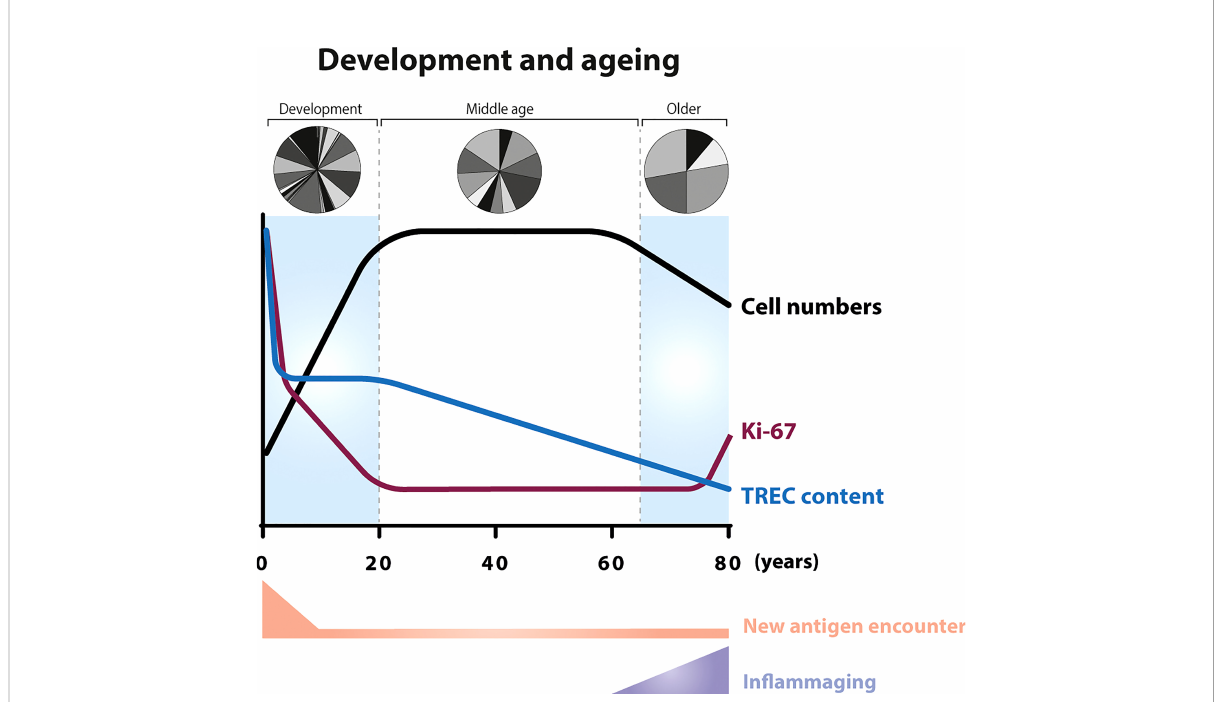
FIGURE 2 T-cell dynamics during ageing In neonates, the number of T cells increase as the body increases in size (34) (black line). The fi rst weeks after birth, new-borns encounter a relatively large number of new antigens compared to later stages in life. In the foetus, the average T-cell receptor excision circle (TREC) content of CD4 + and CD8 + T cells (blue line) is relatively high (36) and, in new-borns, the majority of circulating T cells are naive (40). The fraction of proliferating T cells, as measured by Ki-67 expression, is 5-times higher in new-borns compared to adults (purple line). After the fi rst half year of life, the percentage of Ki-67 positive T cells starts to decrease and stabilizes at adult age (36, 41, 42). Advanced age (above 70 years) is associated with a decline in T-cell numbers (43, 44), a reduced fraction of naive T cells (45), an increase in the percentage of Ki-67 positive cells (46, 47), and with persistent low level in fl ammation (in fl ammaging). With the gradual loss of thymopoiesis during ageing (33, 48), the TREC content decreases in an exponential fashion between the age of 20 and advanced age (13, 49). New-borns have been shown to have a greater repertoire diversity than young adults (39), while older individuals show skewing in the distribution of the clonal sizes